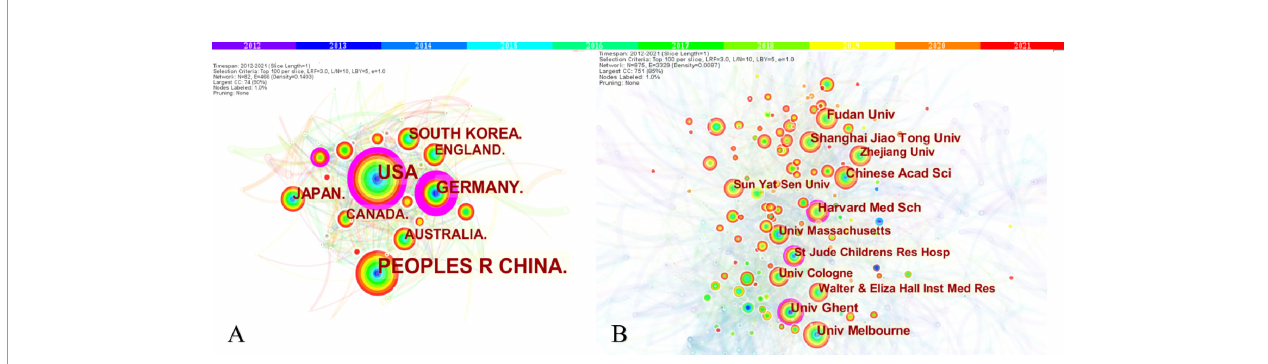
FIGURE 3 | The co-occurrence map of countries/regions (A) and institutions (B) in necroptosis research. (A) Country/regions (n ≥ 100); (B) Institution (n ≥ 50). The node size re fl ects the co-occurrence frequencies, and the links indicate the co-occurrence relationships. The color of node and line represent different years; colors vary from purple to red as time goes from 2012 to 2021, and nodes with purple round mean high betweenness centrality ( ≥ 0.1).